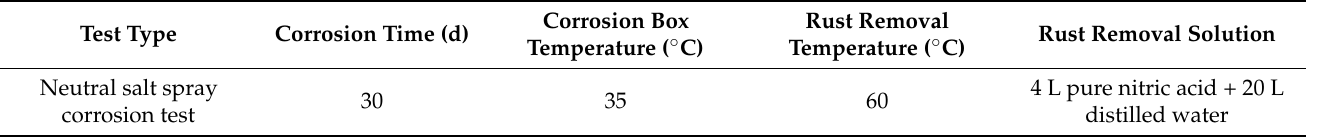
Table 4. Test parameters for salt spray corrosion.